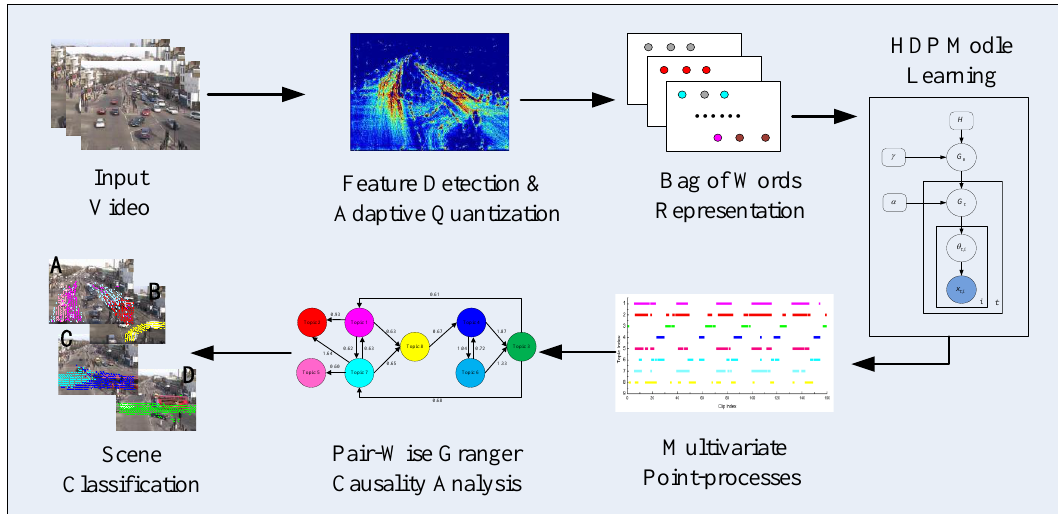
Figure 1. Flowchart of the proposed